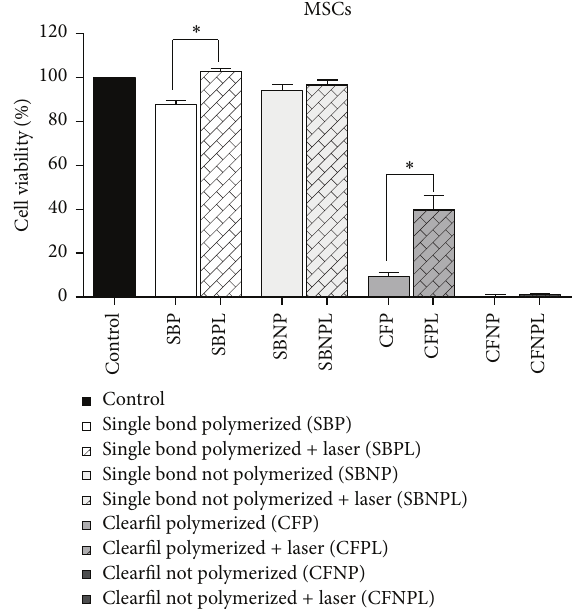
Figure 3: Graphic representation of the cell viabilities of MSCs in response to the substances leached from the dental adhesives: Adper Single Bond 2 and Clearfil SE Bond, whether or not polymerized and followed by LPT or not. ∗ Significantly different from the nonirradiated group submitted to the same adhesive system.